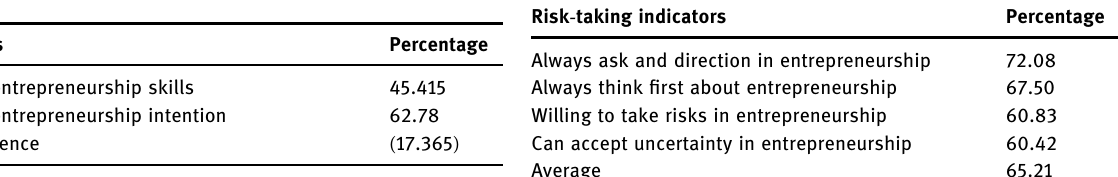
Table 6: Gap between entrepreneurship skills and intentions of poor farmers ( % ) Indicators Average entrepreneurship skills